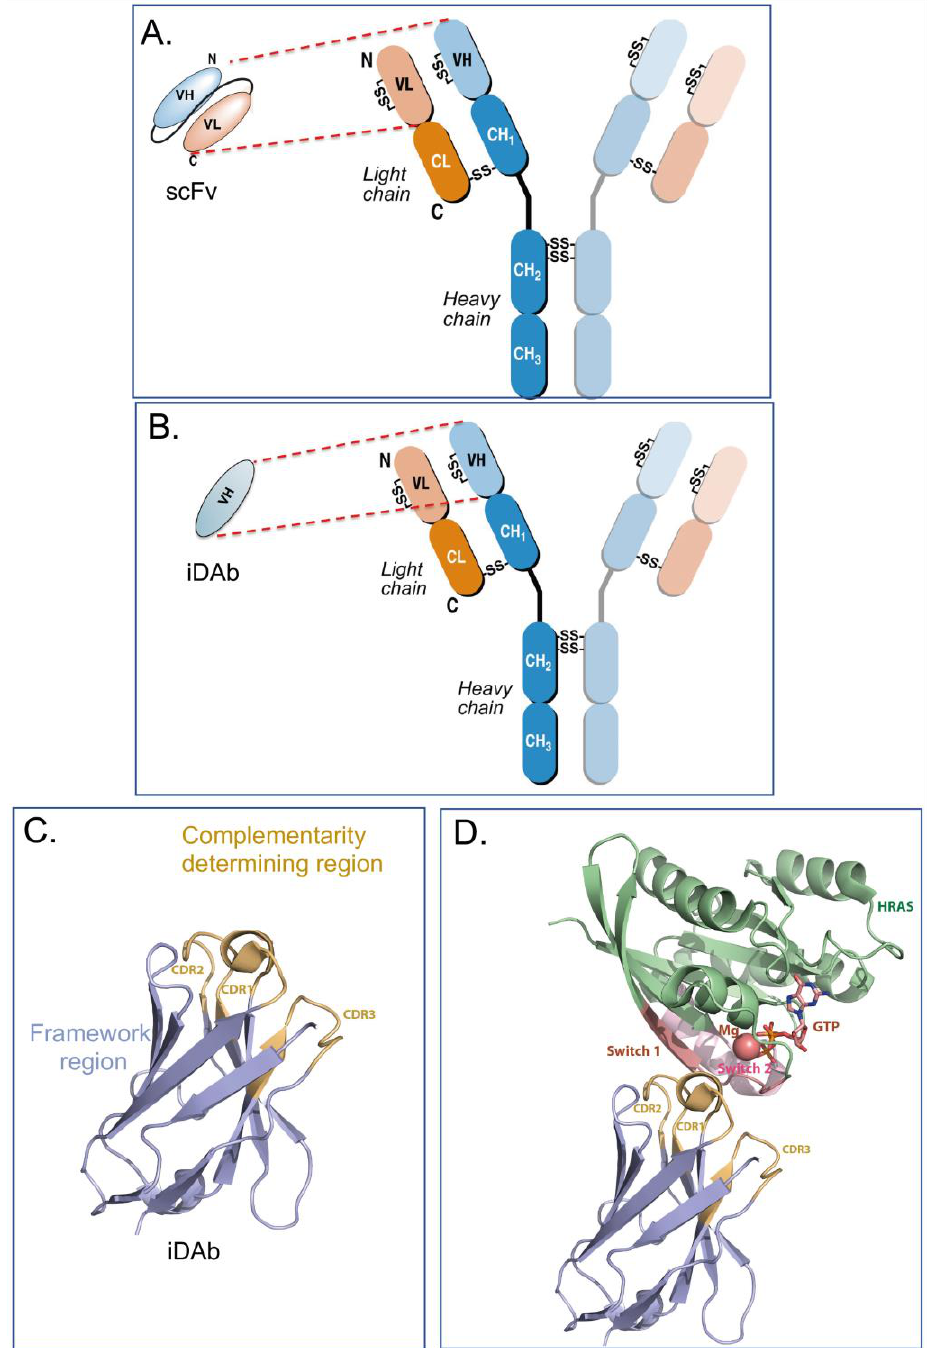
Figure 1. Antibody, intracellular antibody fragments and structure of a consensus human intracellular domain antibody. Immunoglobulins comprise two H and two L chains held together by inter-chain disulphide bonds (panel ( A , B )). The H chain has a V region and different C-region domains (panels ( A , B ) show subclass IgG1 as CH1, 2 and 3 with a hinge region between CH1 and CH2). An intra-chain disulphide bond is found in each V region. Antibody fragments used for intracellular antibodies are either scFv (shown in panel ( A )), where the V regions of H and L chains are held in a single polypeptide chain by a short linker between VH and VL), or a domain antibody, most often VH only (panel ( B )). Using intracellular antibody selections based on intra- cellular antibody capture in yeast [7], a consensus VH sequence was derived by comparing the amino acids at each position in the framework residues of several human iDAbs. Panel ( C ) shows the crystal structure of an iDAb VH that binds to the RAS isoforms and the crystal structure of this VH in contact with HRAS [20]. Panel ( D ) shows crystal structure of GTP-bound HRAS interacting